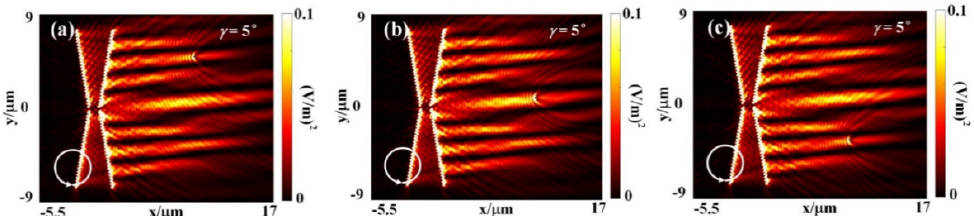
Figure 7. The intensity distribution of nondiffracting SPP beams when there is a cylinder obstacle on the SPP beam’s transmission path. ( a , c ) The self-healing ability of the side lobe SPP beam. ( b ) The self-healing ability of the main lobe SPP beam.